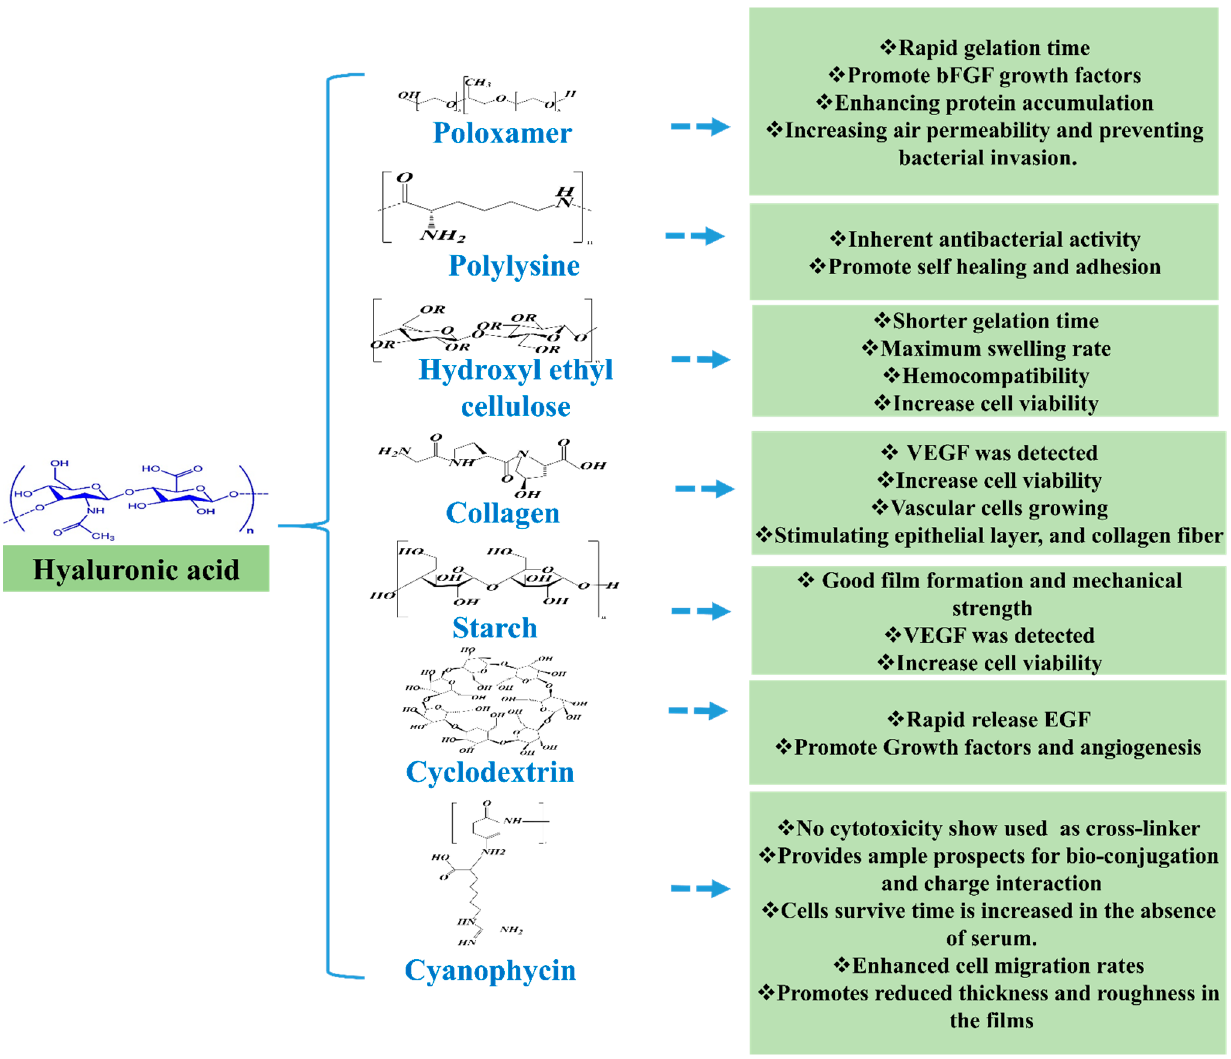
Figure 8. summarizes HA/polymers structure and significant properties in the wound healing pro-